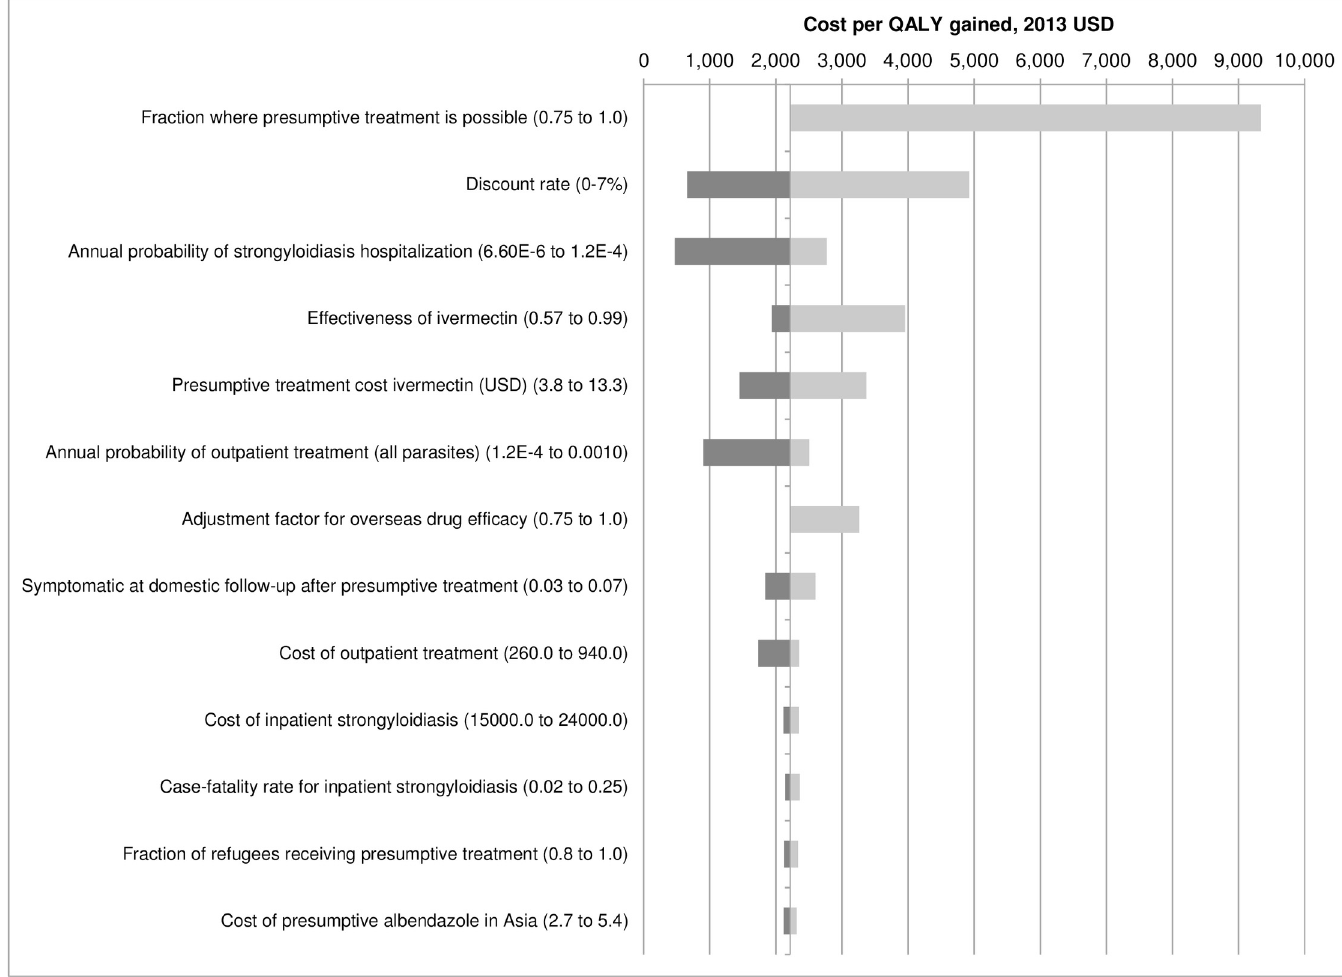
Fig 2. One-way sensitivity analysis of cost per QALY gained, 2013 USD a . a The tornado diagram is a series one-way sensitivity analyses in which parameters are varied (one at a time across their uncertainty ranges while holding all other parameters at their base case